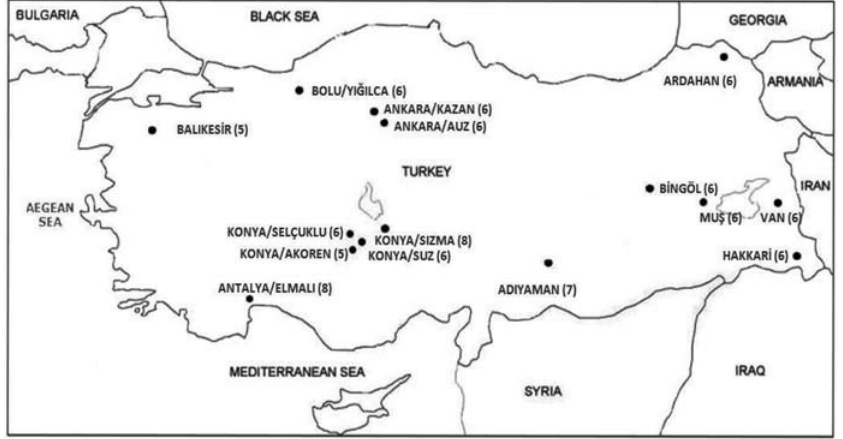
Fig. 1 . Sampling locations in Turkey. Number in parenthesis show the number of colonies sequenced at each